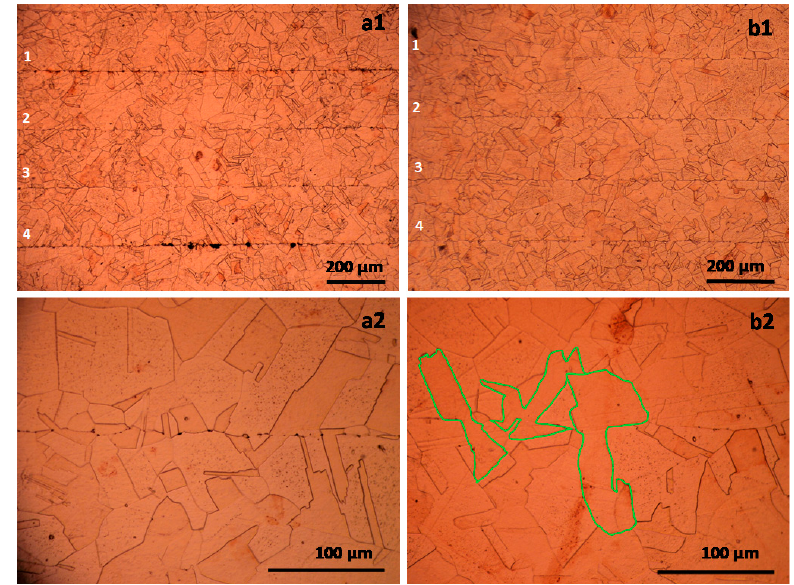
Figure 3. Metallographic micrographs of Cu-Cu bond cross sections presenting the interfaces between the copper layers. Bonding conditions: sample ( a ) 935 ◦ C / 45 min, sample ( b ) 935 ◦ C / 90 min (the numbering corresponds to the bonding